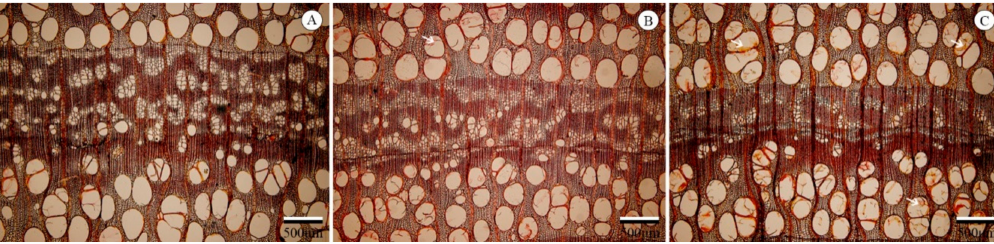
Figure 1. Transversal sections of wood blocks from sapwood ( A ), transition wood ( B ) and heartwood ( C ) in a radial strip at 6.3 m height in C. bungei . Tyloses were rarely distributed in sapwood, gradually reduced in the transition zone and common in the vessel lumen of heartwood. Arrows represent locations of tyloses.